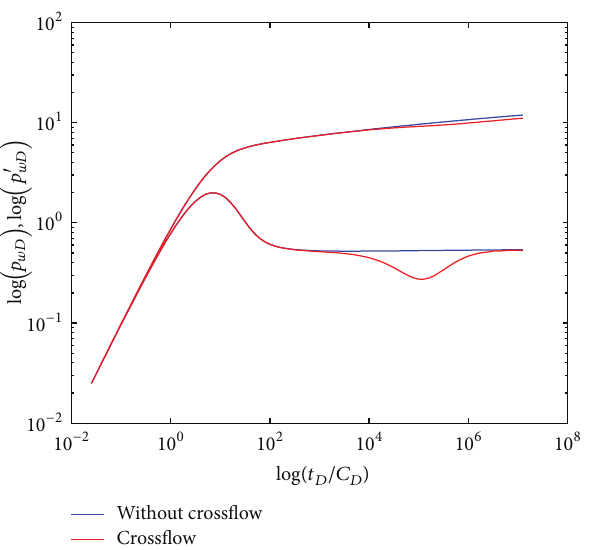
Figure 6: Effect of formation coefficient ratio ( 𝜒 ) on type